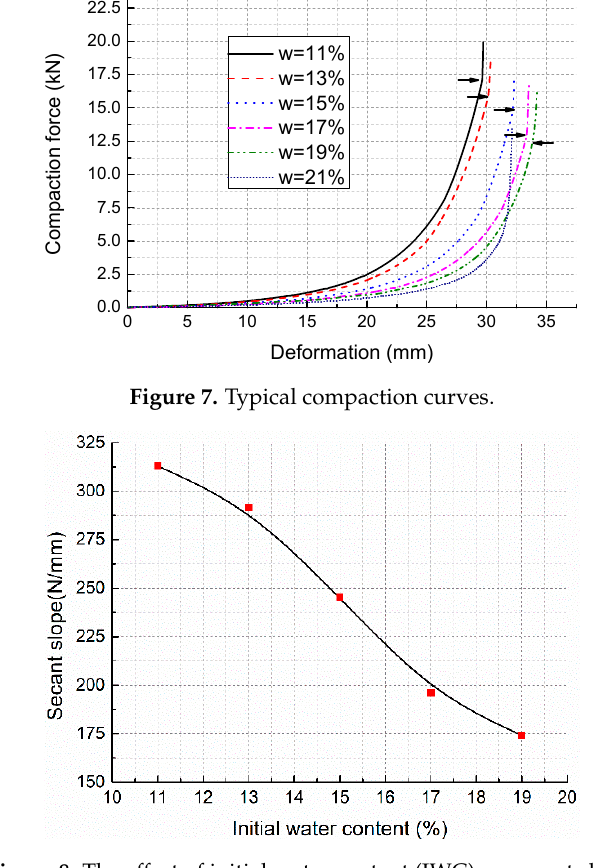
Figure 8. The effect of initial water content (IWC) on secant slope.